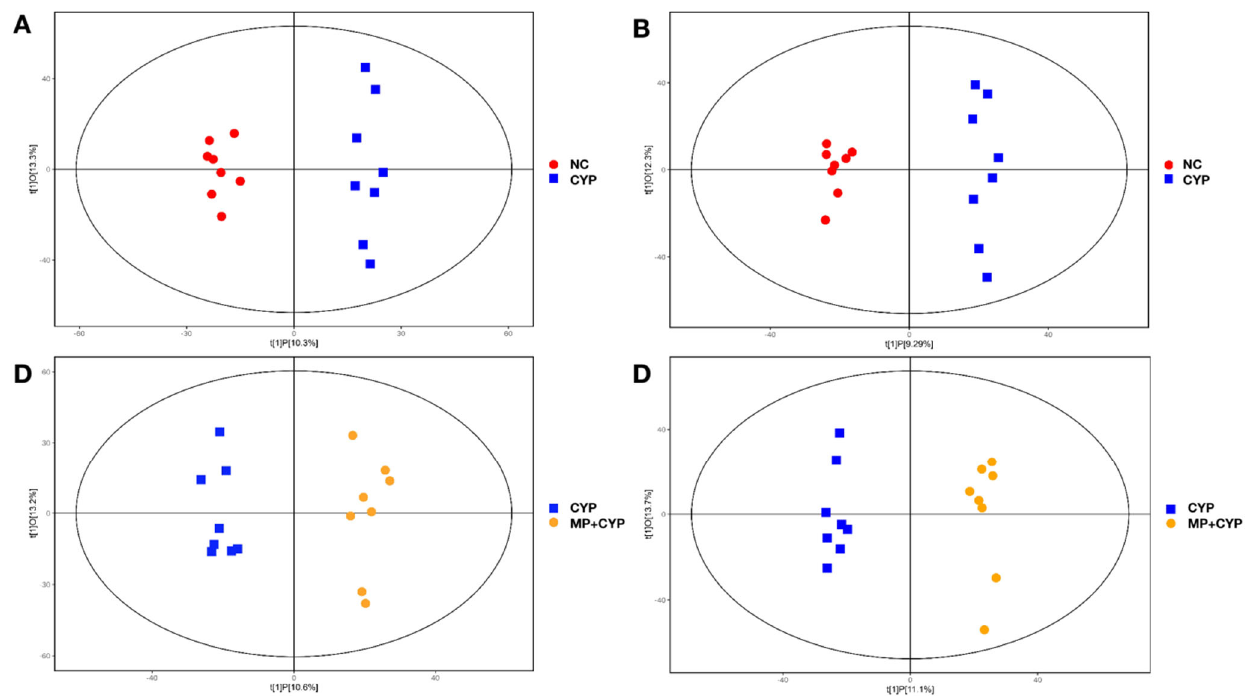
Figure 8. The OPLS ‐ DA score plots. ( A ) NC and CYP Model groups in ESI + mode; ( B ) NC and CYP Model groups in ESI − mode; ( C ) CYP Model and MP+CYP groups in ESI+ mode; ( D ) CYP Model and MP+CYP groups in ESI − mode.